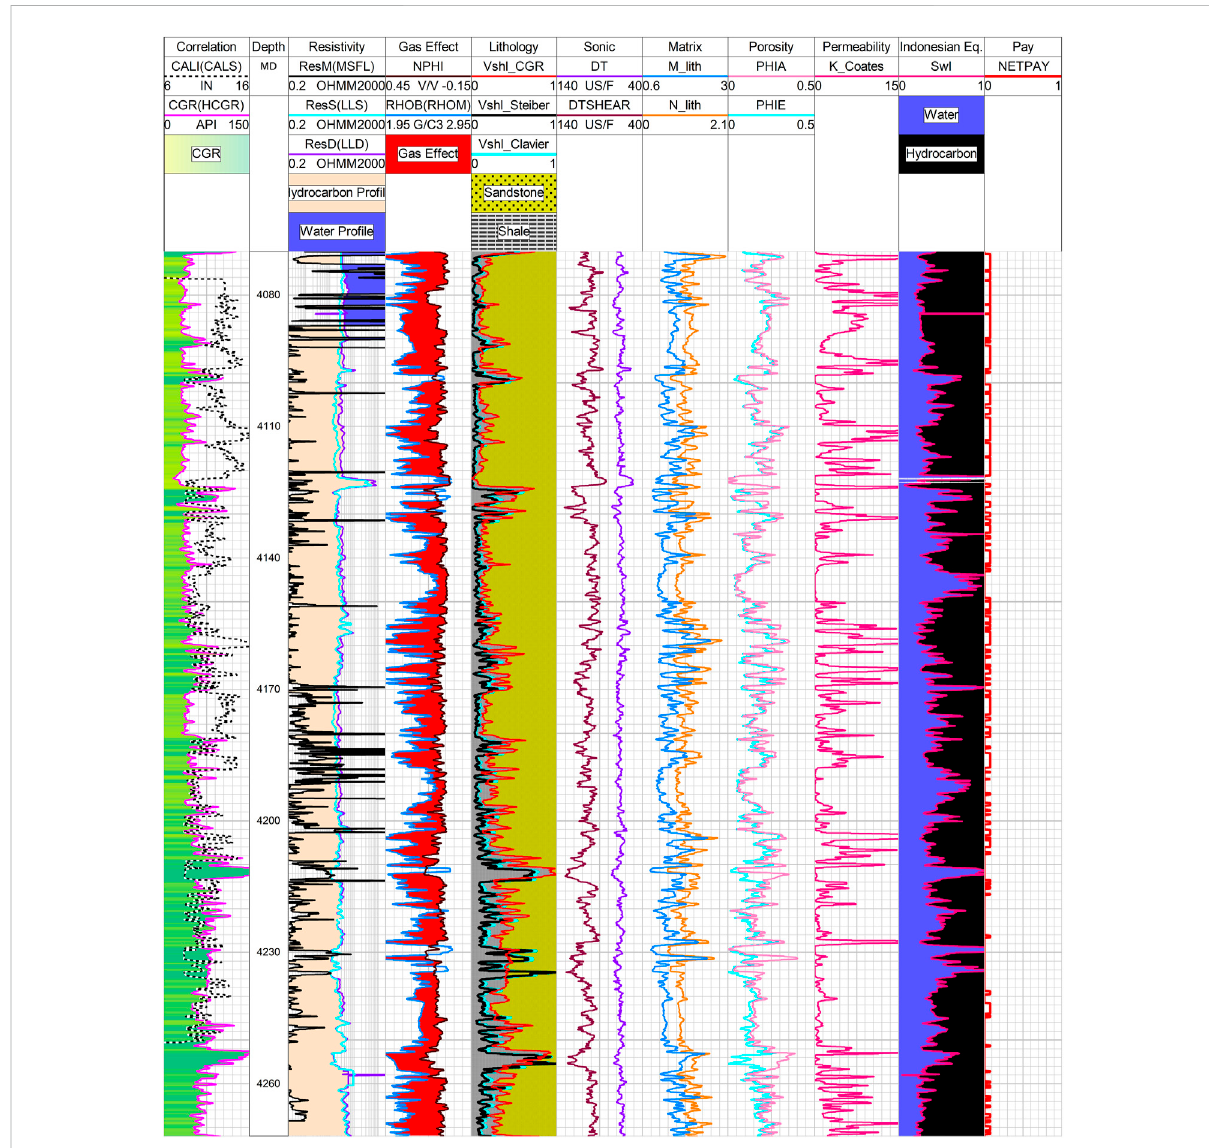
Frontiers in Earth